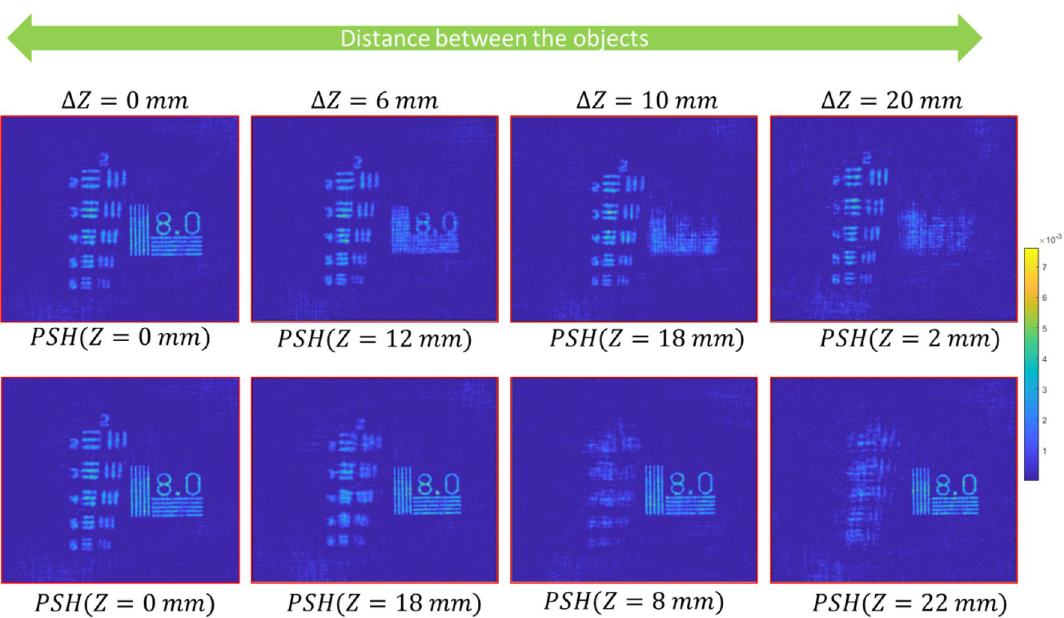
Figure 7. 3D Reconstruction results of SCI-COACH system with an annular aperture of 300 pixels. Two objects are placed in different axial planes with varying separation between two